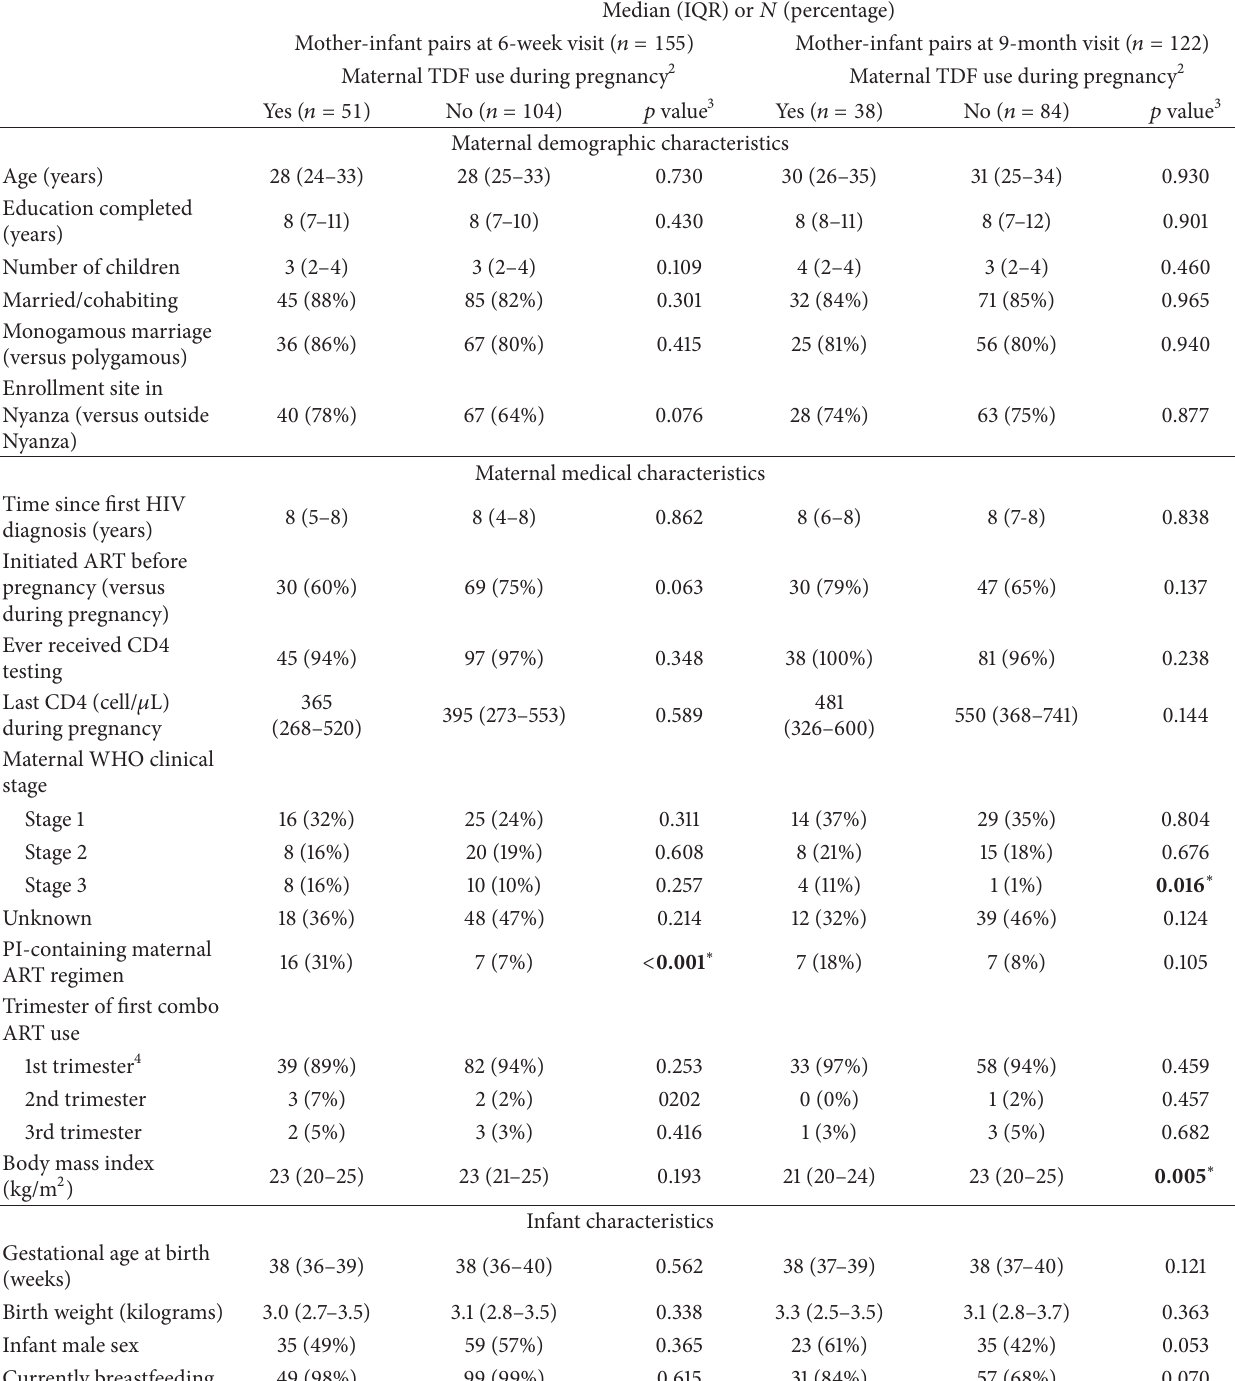
Table 1: Distribution of demographic and medical characteristics by any maternal prenatal TDF use, among HEU infants exposed for combination ART 1